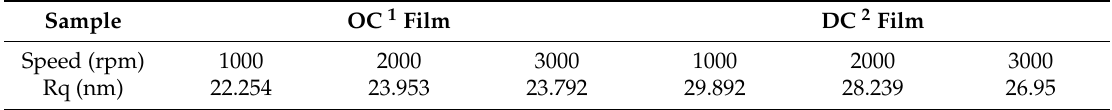
Figure 6. The surface morphologies of atomic force microscope (AFM) with different spin ‐ coating speeds based on OC TiO 2 film from ( a ) to ( c ) and DC TiO 2 film from ( d ) to ( f ). Table 2. Surface roughness from AFM measurement for OC and DC TiO 2 film. Sample